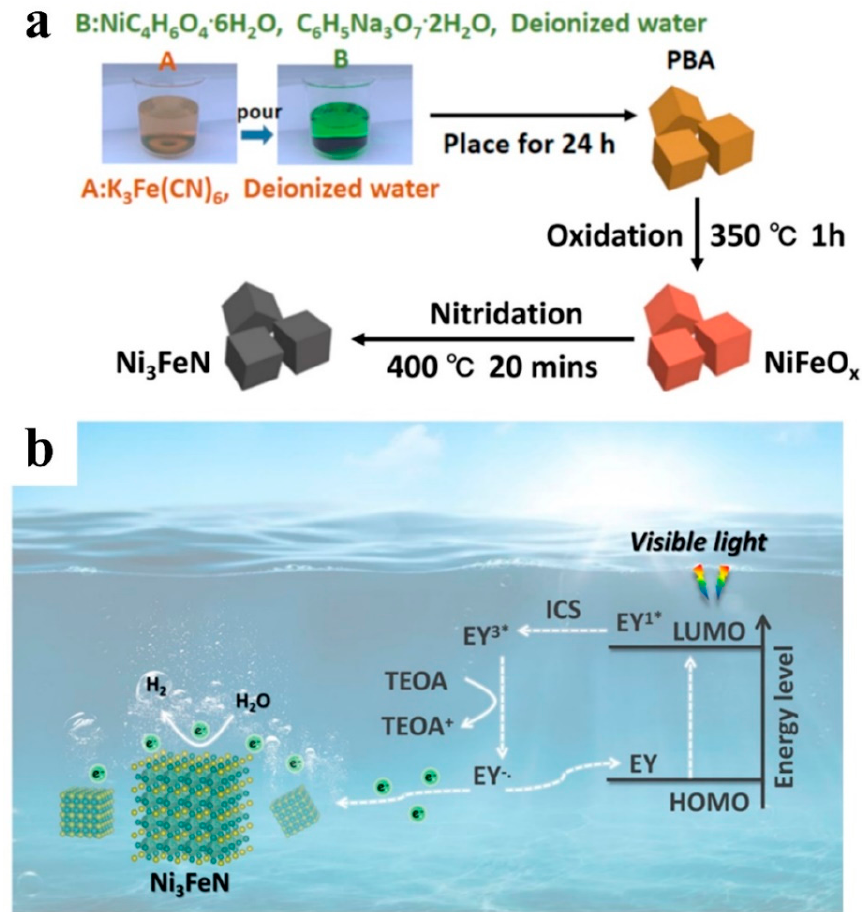
Figure 16. ( a ) The synthesis schematic illustration of the Ni 3 FeN. ( b ) A possible mechanism of photocatalytic Eosin-Y-sensitized hydrogen evolution based on the Ni 3 FeN catalyst. Reproduced with permission from Ref. [85].